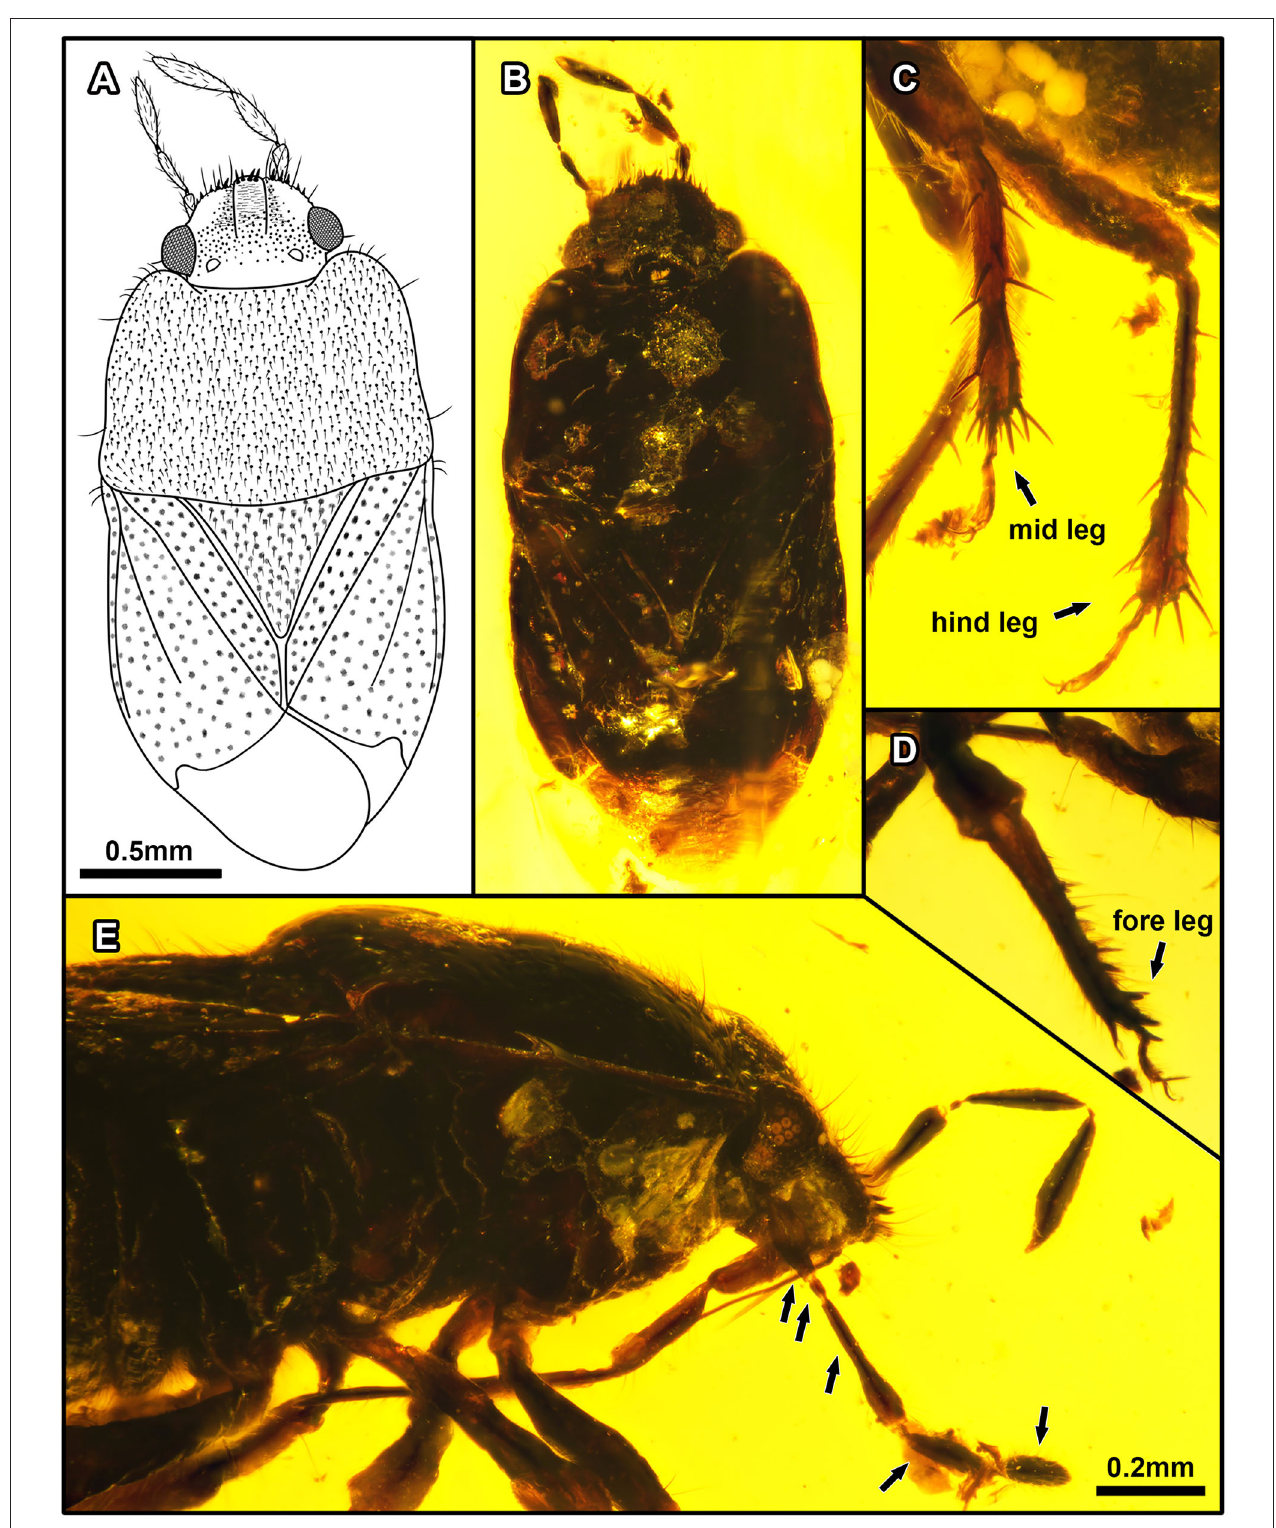
FIGURE 3 | Acanthamnestus ovoideus gen. et sp. nov., in Burmese amber. Holotype, CNU-HET-MA2019003 (female). (A) Line drawing in dorsal view. (B) Habitus in dorsal view. (C) Meso- and metatibiae. (D) Protibiae. (E) Habitus in right lateral view of head, arrows indicate five antennomeres. Scale bars: A = B = 0.5mm; C = D = E =